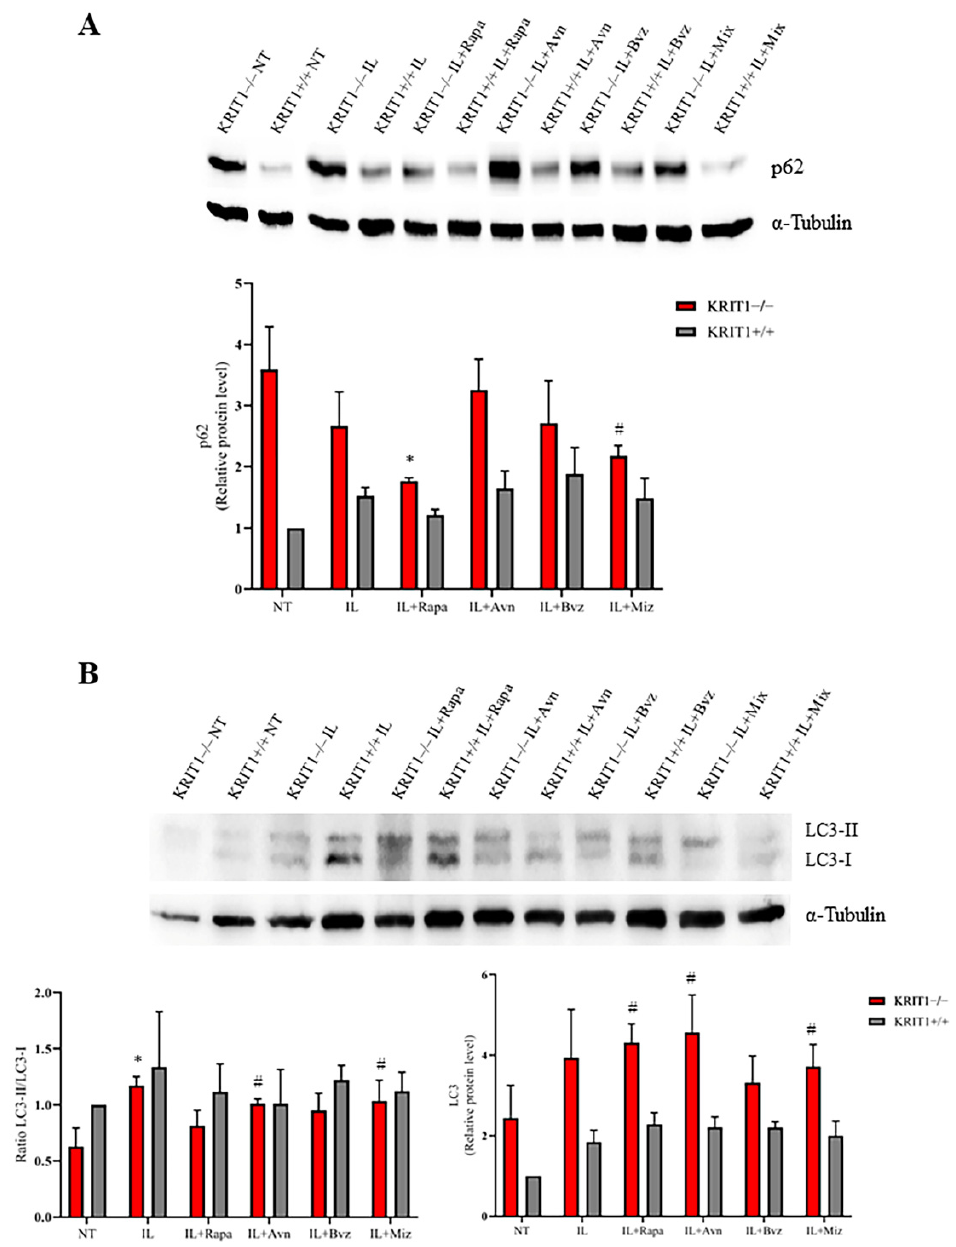
Figure 3. ( A ) Immunoblot analysis and representative histogram of the autophagic marker Sequestosome-1 (p62) in KRIT1-knockout (KRIT1 − / − ) and KRIT1-overexpressing (KRIT1+/+) mouse embryonic fibroblasts (MEFs) untreated (Ctrl) or treated for 24 h with injectable nanoemulsions (ILs) loaded with rapamycin (Rapa), bevacizumab (Bvz), yeast avenanthramide I (Avn), or with a combination of all three compounds (herein referred to as Mix) to a final concentration of: Avn = 15 µg/mL (50 µM), Rapa = 0.46 µg/mL (500 nM), Bvz = 10 µg/mL (70 nM). After treatment, cells were lysed, as described in Materials and Methods, and analyzed for the indicated proteins by Western blot (WB) analysis. ( B ) Immunoblot analysis and histogram representing the quantitative evaluation by densitometric analysis of light chain 3 (LC3) total protein expression levels and the ratio between LC3-II and LC3-I. Quantifications are relative protein level units referring to the average value obtained for KRIT1+/+ samples. α -tubulin was used as internal loading control for WB normalization. Statistical analysis: treatments vs. NT in KRIT − / − MEFs: # p < 0.1; * p <